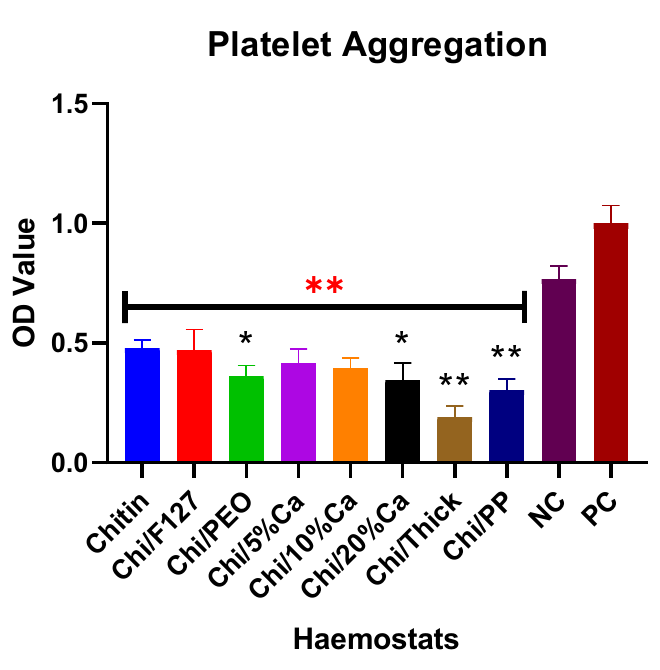
Figure 6. The effect of chemical and structural modification on the platelet aggregating ability of the beta- chitin patch, as measured by LDH assay. The OD value of non-modified beta-chitin patch (chitin), Chi/F127, Chi/PEO, Chi/5%Ca, Chi/10%Ca, Chi/20%Ca, Chi/Thick, Chi/PP and negative control (NC) are normalised to positive control (PC). *p < 0.05 and **p < 0.001, compared to non-modified beta-chitin patch and **p < 0.001, compared to positive (10% Triton-X100 in PBS) and negative (0.9% Triton-X100 in PBS) control, analysed by Kruskal–Wallis one-way ANOVA with Dunn’s test, n =